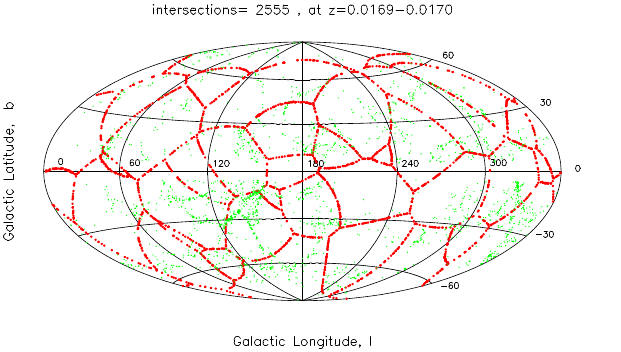
Figure 6. The 2555 galaxies of 2MRS at 0.0169 < z < 0.0170 (green points) and the same number of V P , s (2, 3) in the Hammer–Aitoff projection (red points). The parameters are given in Table 2.